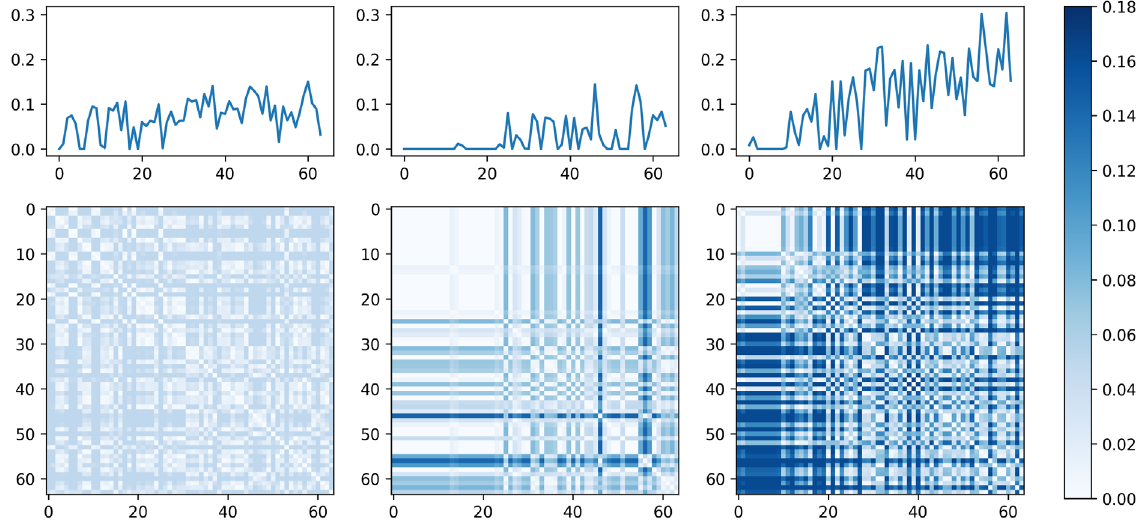
FIG. 8. Examples of recurrence plots (bottom row) generated from the original signals (top row) by the RPCNN model. From left to right: uncorrelated stochastic data, data starting to grow, and stochastic data with a linear trend (from [66], Fig.